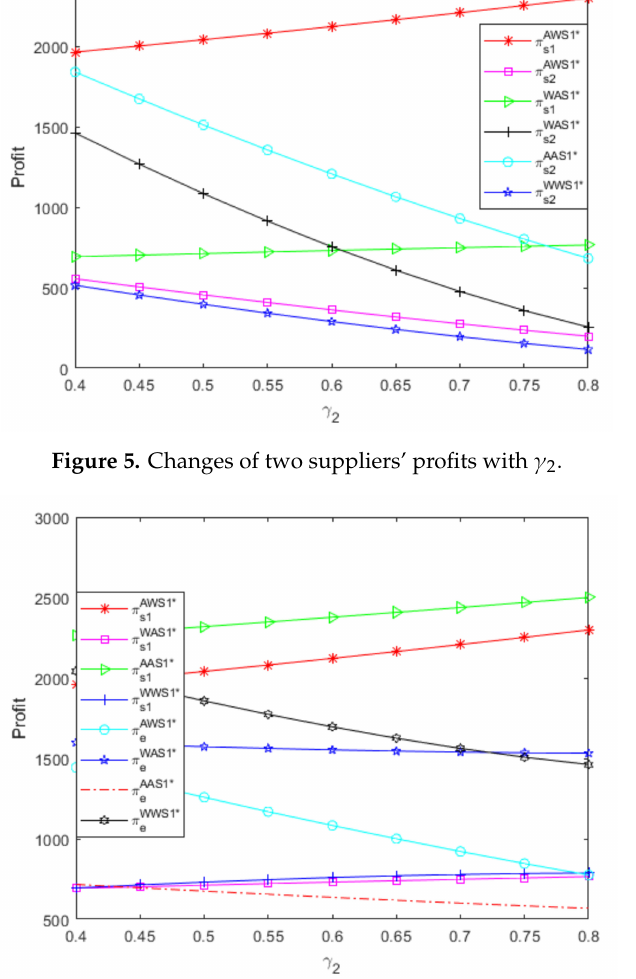
Figure 6. Changes of supplier 1’s and e-retailer’s profits with γ 2